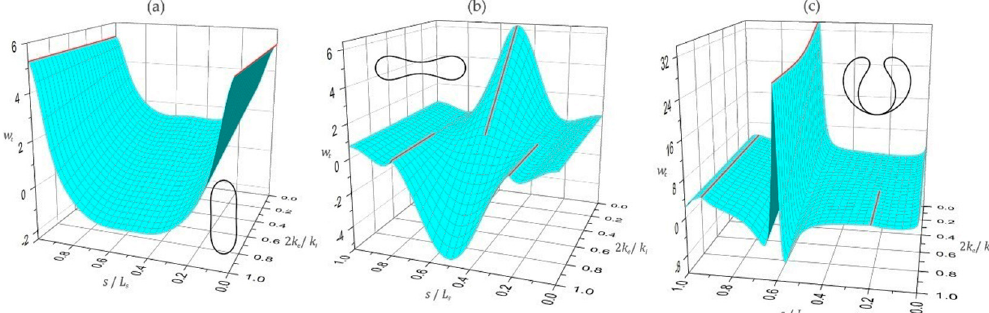
Figure 2. Extrinsic potential 𝑤 (cid:3032) as a function of the arc length 𝑠 and the nematic director orienta- tion angle 𝜃 for ( a ) prolates, ( b ) oblates and ( c ) stomatocytes. Shell profiles are given within graphs for each shape. 𝐿 (cid:3046) stands for the length of the profile curve.